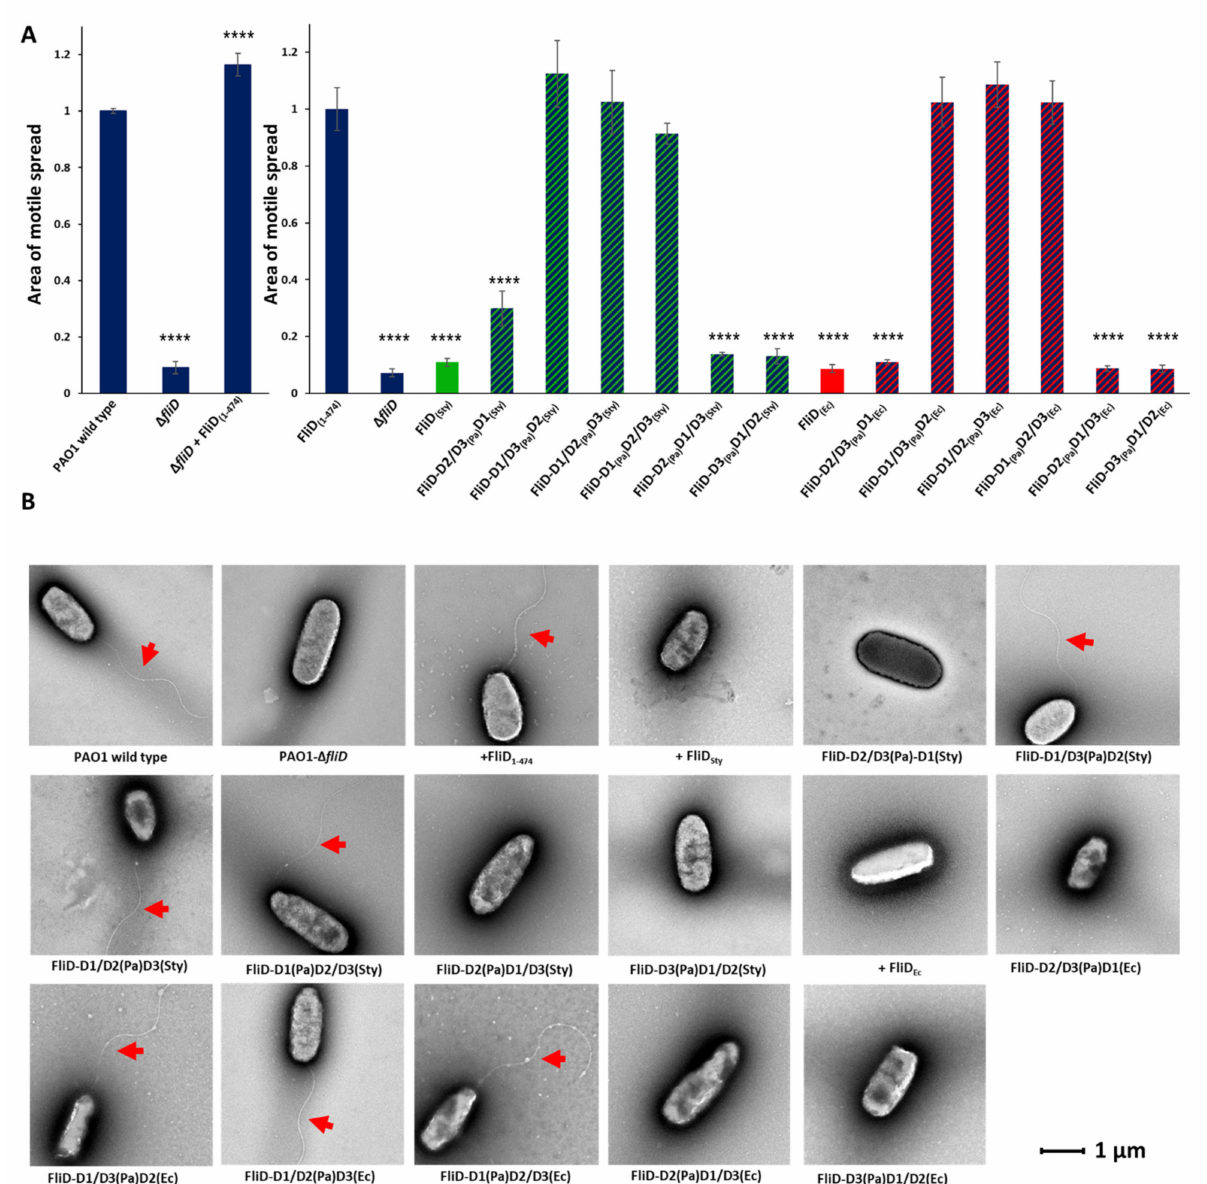
Figure 2. Effects of FliD head/plate domain swaps in flagellar formation and function. ( A ) Swimming motility analysis and ( B ) negative-stain EM images of knockout and complemented P. aeruginosa PAO1 strains. Origin of each domain (D1, leg domain; D2, first head/plate domain; D3, second head/plate domain) in the chimeric fliD gene in each complement is indicated. Area of motile spread for each strain is normalized to that of the full-length wild type complemented strain [ Pa ∆ fliD / fliD Pa (1-474)]. (**** p <